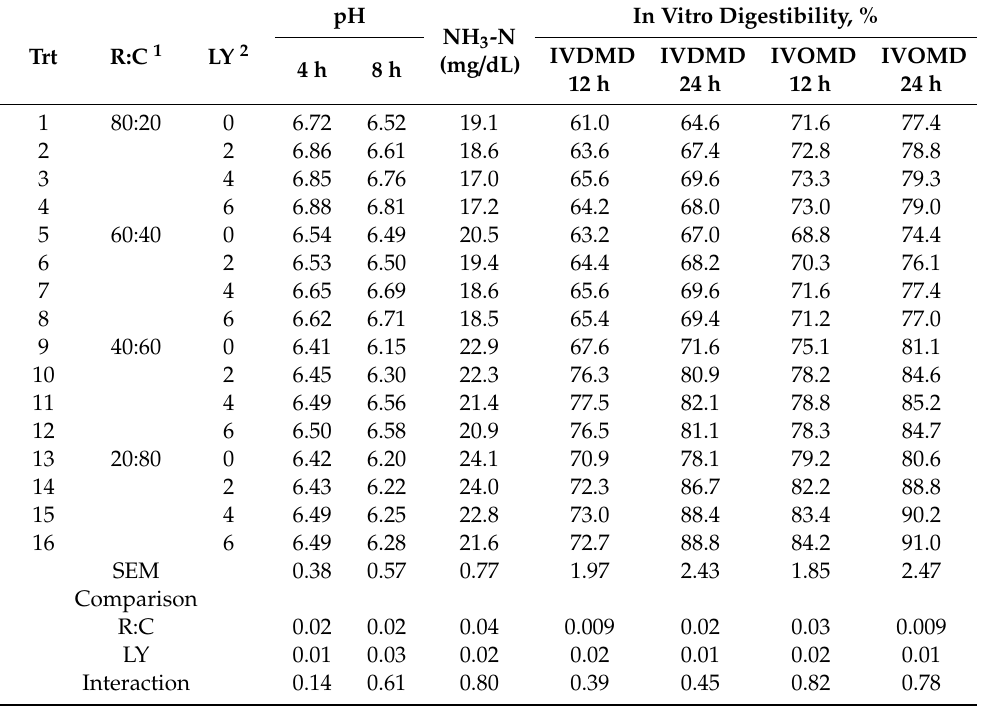
Table 3. The e ff ect of roughage-to-concentrate (R:C) ratio with live yeast (LY) supplementation on rumen ecology and in vitro